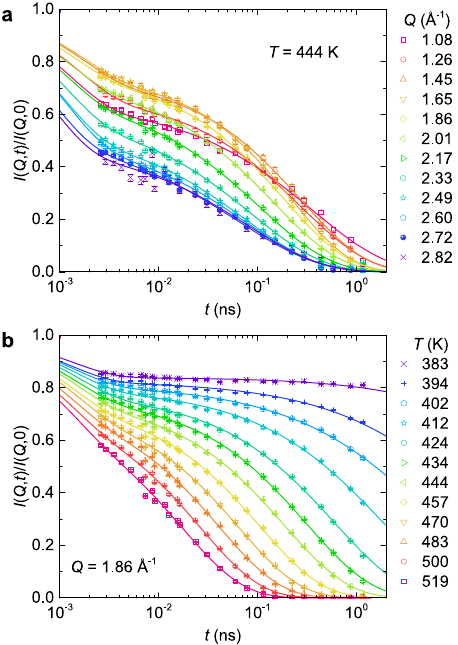
Fig. 2 Representative intermediate scattering functions of CKN. a T = 444 K at various Q ’ s between 1.08 Å − 1 and 2.82 Å − 1 , b Q = 1.86 Å − 1 at various temperatures between 383 K and 519 K. The solid lines represent fi t to Eq. (1). Error bars represent one standard error and are smaller than the symbol size. Source data are provided as a Source Data fi